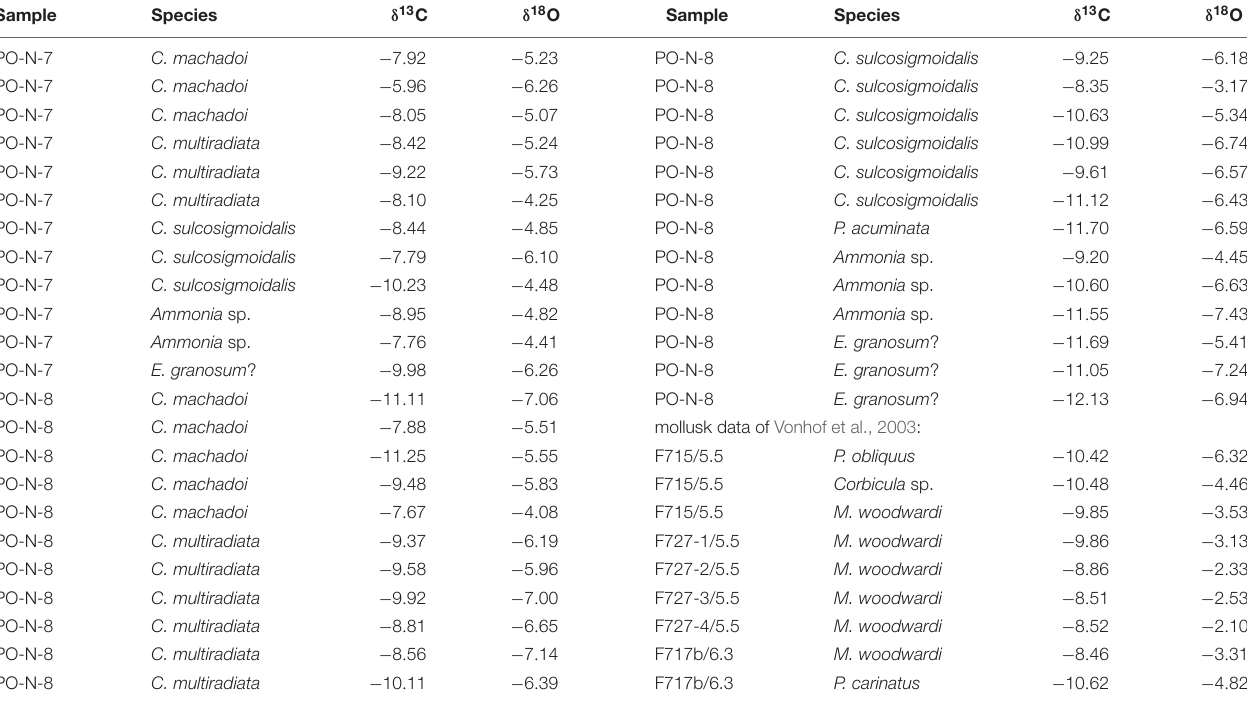
TABLE 1 | δ 18 O- and δ 13 C-isotopic ratios of foraminiferan tests, ostracod valves, and mollusk shells from Porvenir (samples PO-N-7 and 8; mollusk data from Vonhof et al., 2003; section meters 5.5 and 6.3 of Vonhof et al., 2003, correspond approximately to PO-N-7 and